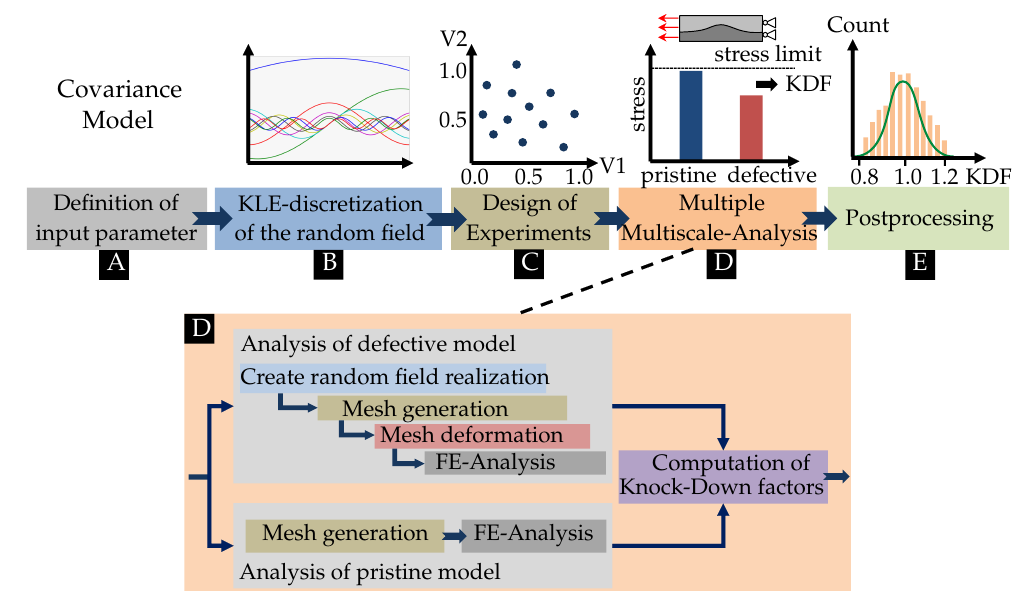
Figure 5. Simplified workflow for the estimation of stochastic knock-down